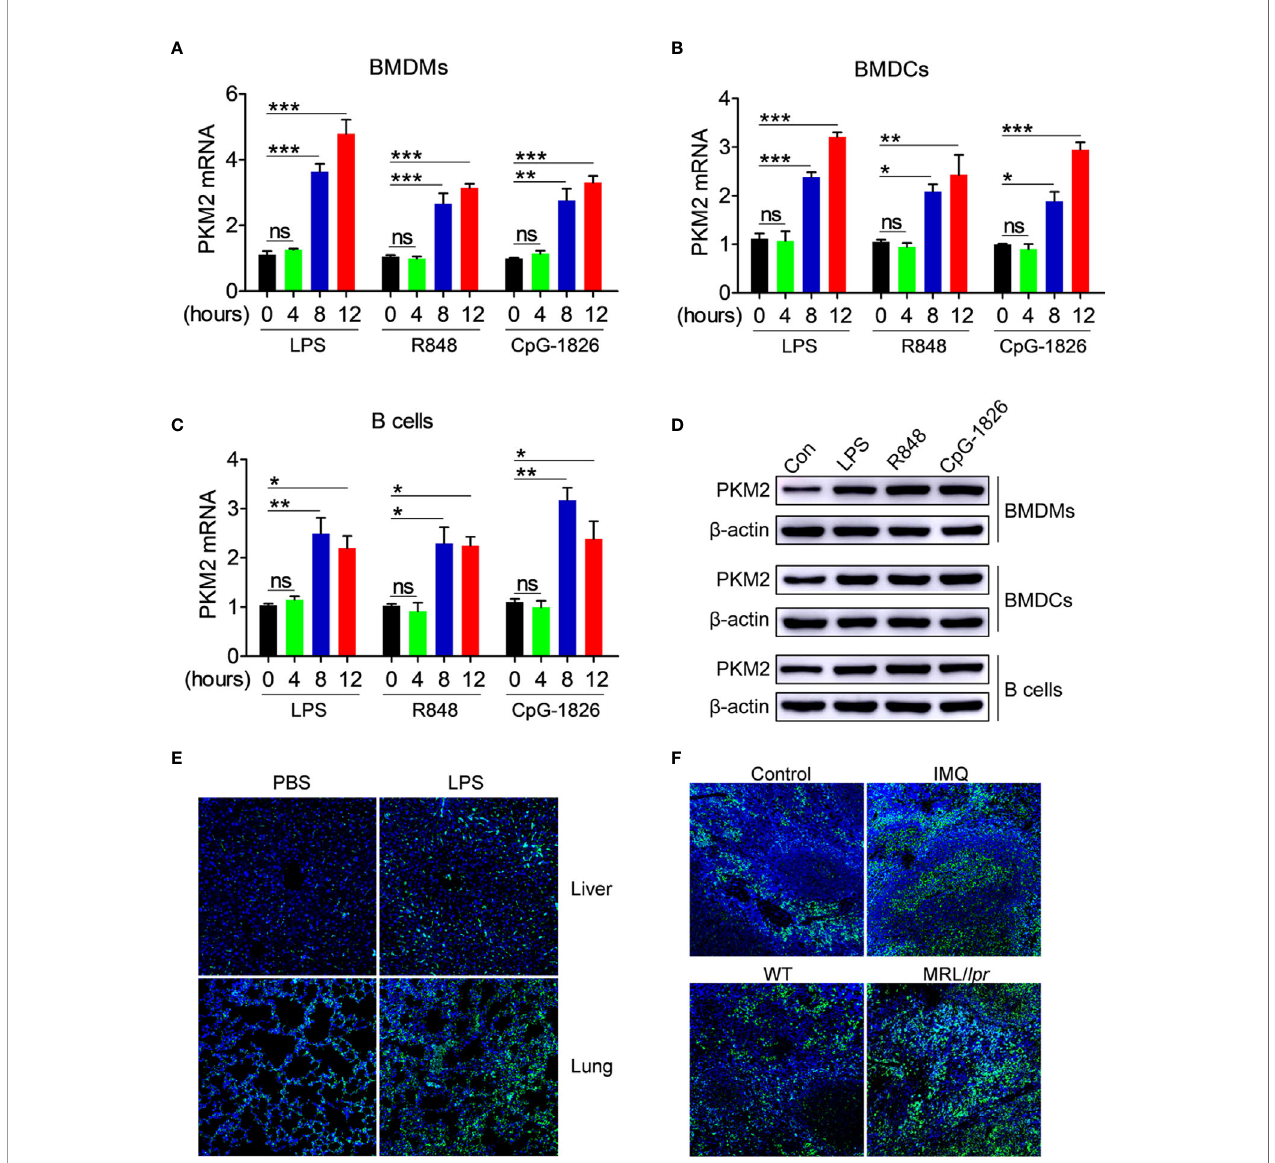
FIGURE 1 | PKM2 expression is induced by TLRs in vitro and in vivo . (A – D) BMDMs, BMDCs and murine splenic B cells were stimulated with LPS (100 ng/mL), R848 (1 m g/mL) and CpG-1826 (1 m M) for different times. Q-PCR analysis of PKM2 expression in BMDMs (A) BMDCs (B) and murine splenic B cells (C) at 4, 8 and 12 hours. Western blot analysis of PKM2 expression in BMDMs, BMDCs and murine splenic B cells at 24 hours (D) . The data shown represent the means of three independent experiments and the error bars represent the S.E.M. (E) Immuno fl uorescence staining to detect the expression of PKM2 in the liver and lung sections from mice challenged by LPS (10 m g/g body weight) for 12 hours. (F) Immuno fl uorescence staining to detect the expression of PKM2 in the spleen sections from mice treated by imiquimod for 8 weeks or lupus-prone MRL/ lpr mice. Blue represents DAPI; green represents PKM2. The data are shown as the means ± SEM (n = 6 mice/group) and are representative of three independent experiments. * p < 0.05, ** p < 0.01, *** p < 0.001, as determined by ANOVA tests; ns denotes p >